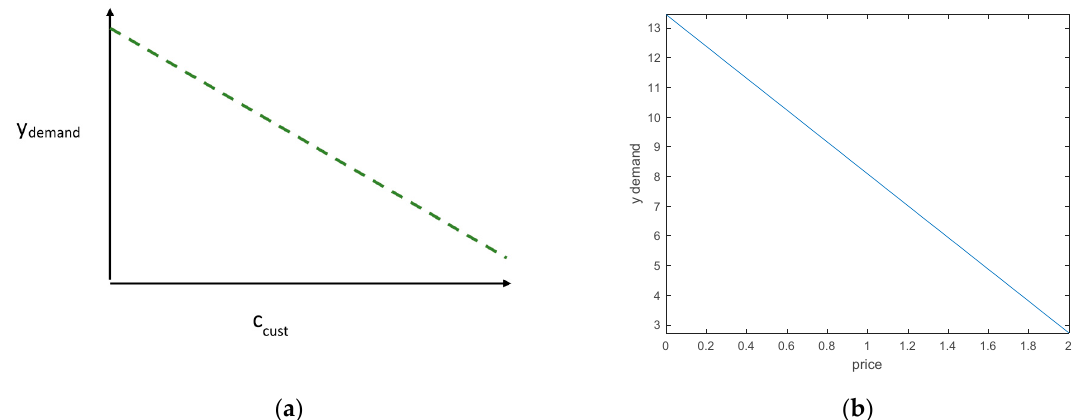
Figure A1. ( a ) Theoretical relationship between price and demand; ( b ) Sample relationship between price and demand using data for “Fresh Oranges”.